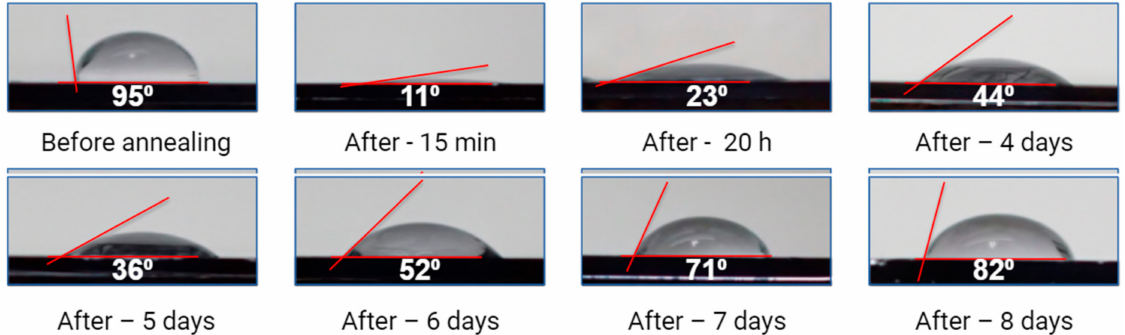
Figure 10. WCAs on Y 2 O 3 before and after different duration of air